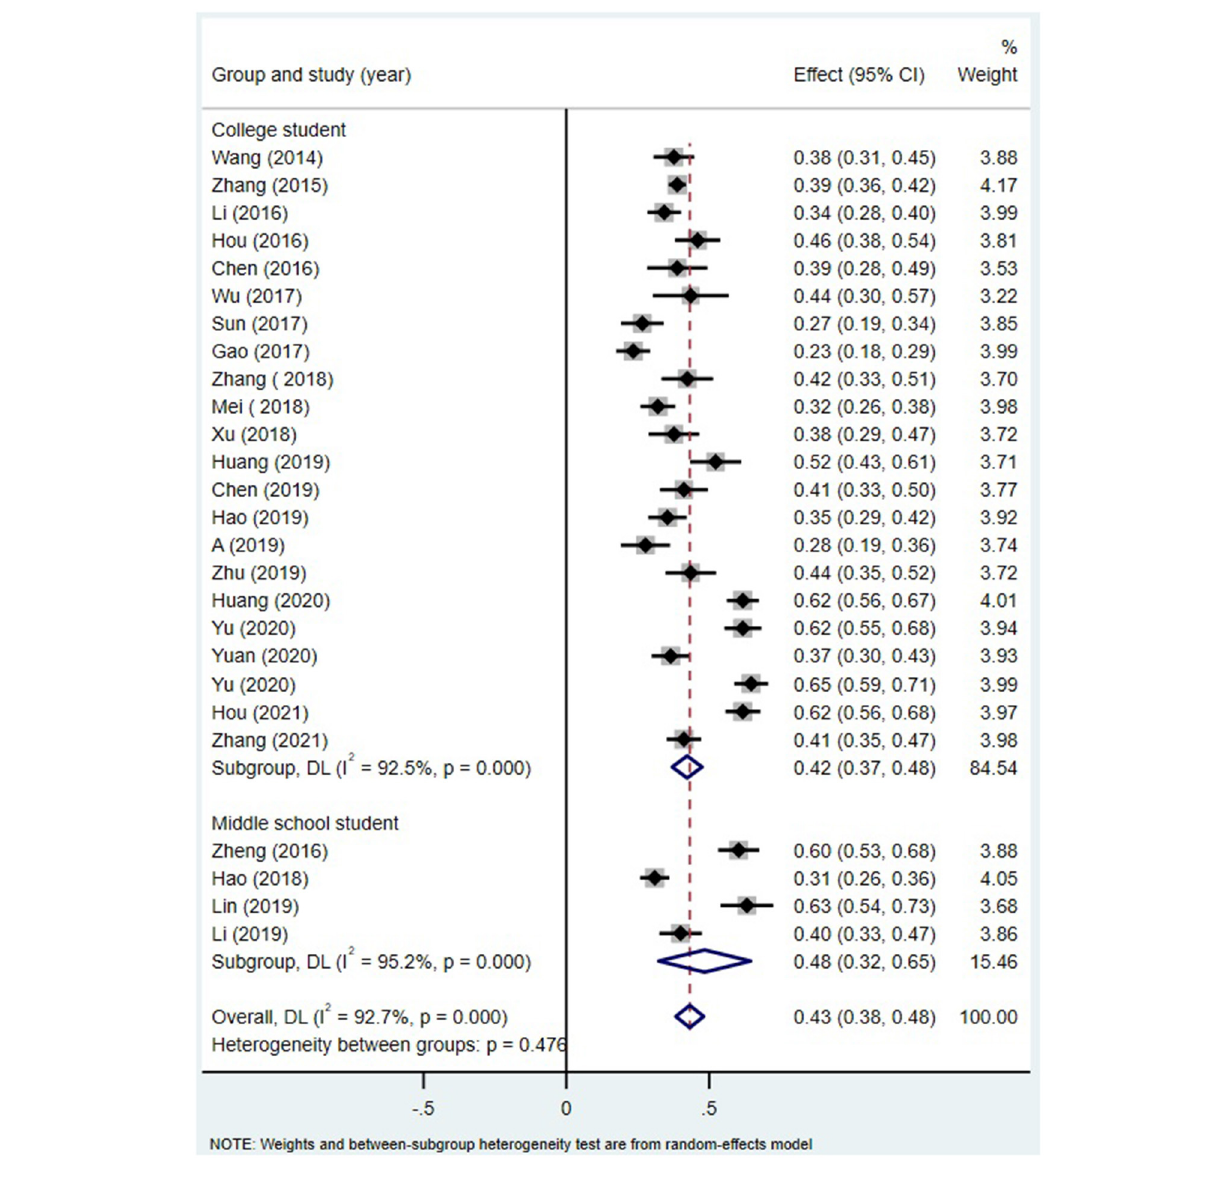
FIGURE 6 | MPA and alexithymia: an analysis of the moderating effects of age